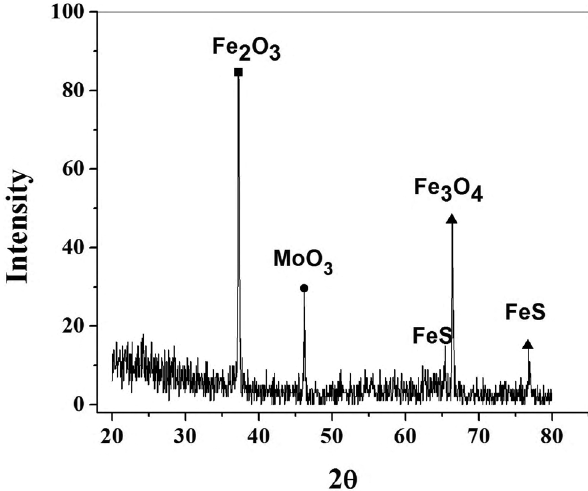
Fig. 6: XRD analysis of the post exposure 50.4% deformed